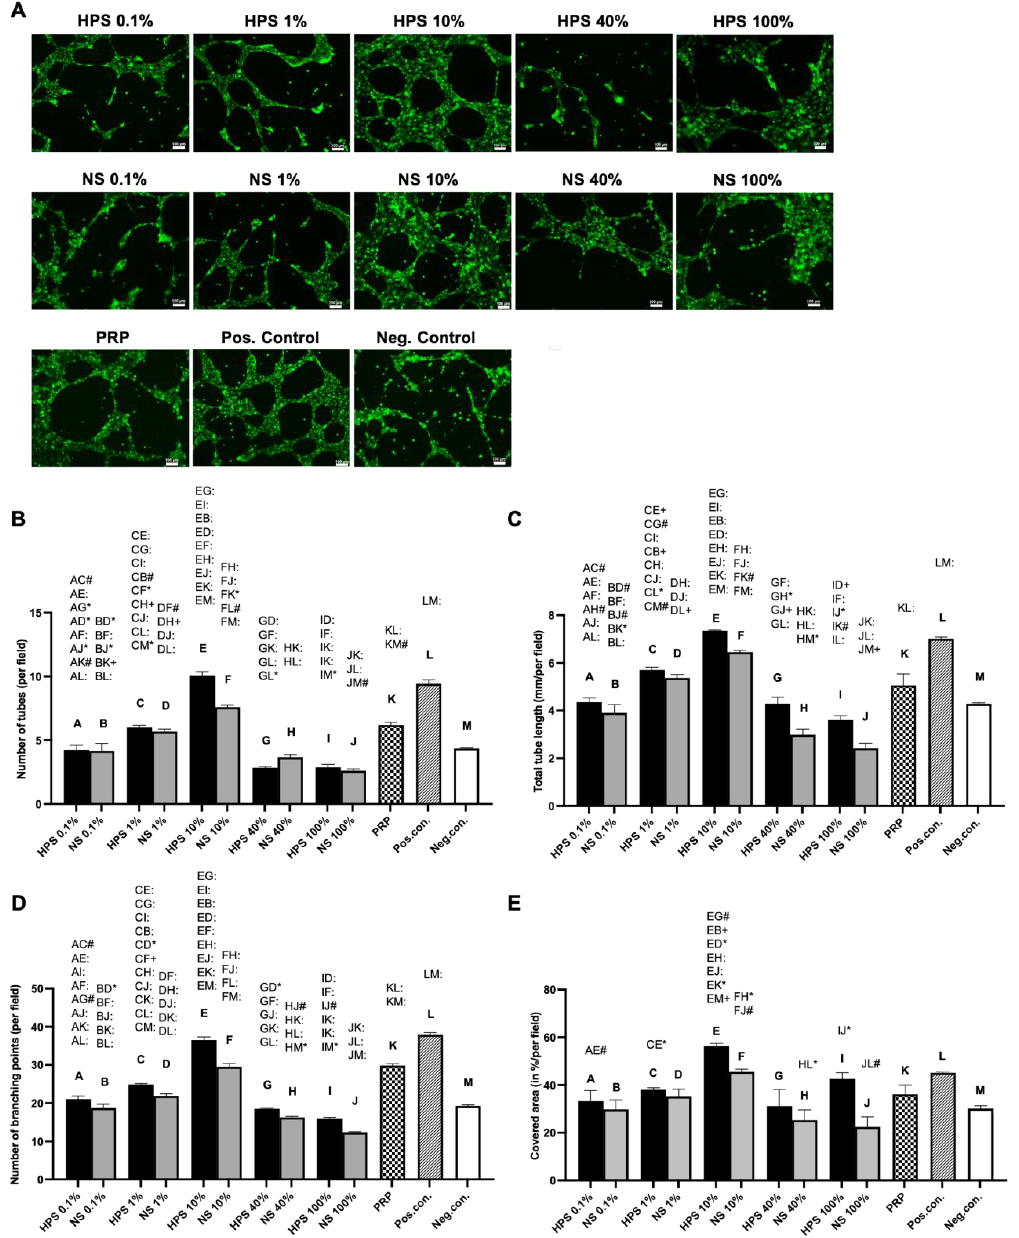
Figure 3. The effect of HPS, NS, and PRP on tube formation in LECs. ( A ) Representative microscopic photographs of the tube formation assay (8 h) of LECs stained by Calcein AM, carried out in the presence of the shown blood-derived secretomes (pooled from ten donors) compared to positive/negative control. Scale bar = 100 μm. ( B – E ) Image analysis of the digital photographs depicted in ( A ): ( B ) Plot showing the number of tubes. ( C ) Plot showing total tube length. The length is measured in mm. ( D ) Plot showing the number of branching points. ( E ) Plot showing percentage of the covered area of LECs. One-way repeated-measures ANOVA with Tukey’s multiple comparison test. Data points are means ± SEM, LEC donors: n = 3. Capital letter pairs over plots indicate statistical comparison of corresponding data points. For all pair comparisons, * = p < 0.05, # = p < 0.01, + = p < 0.001, : = p < 0.0001.